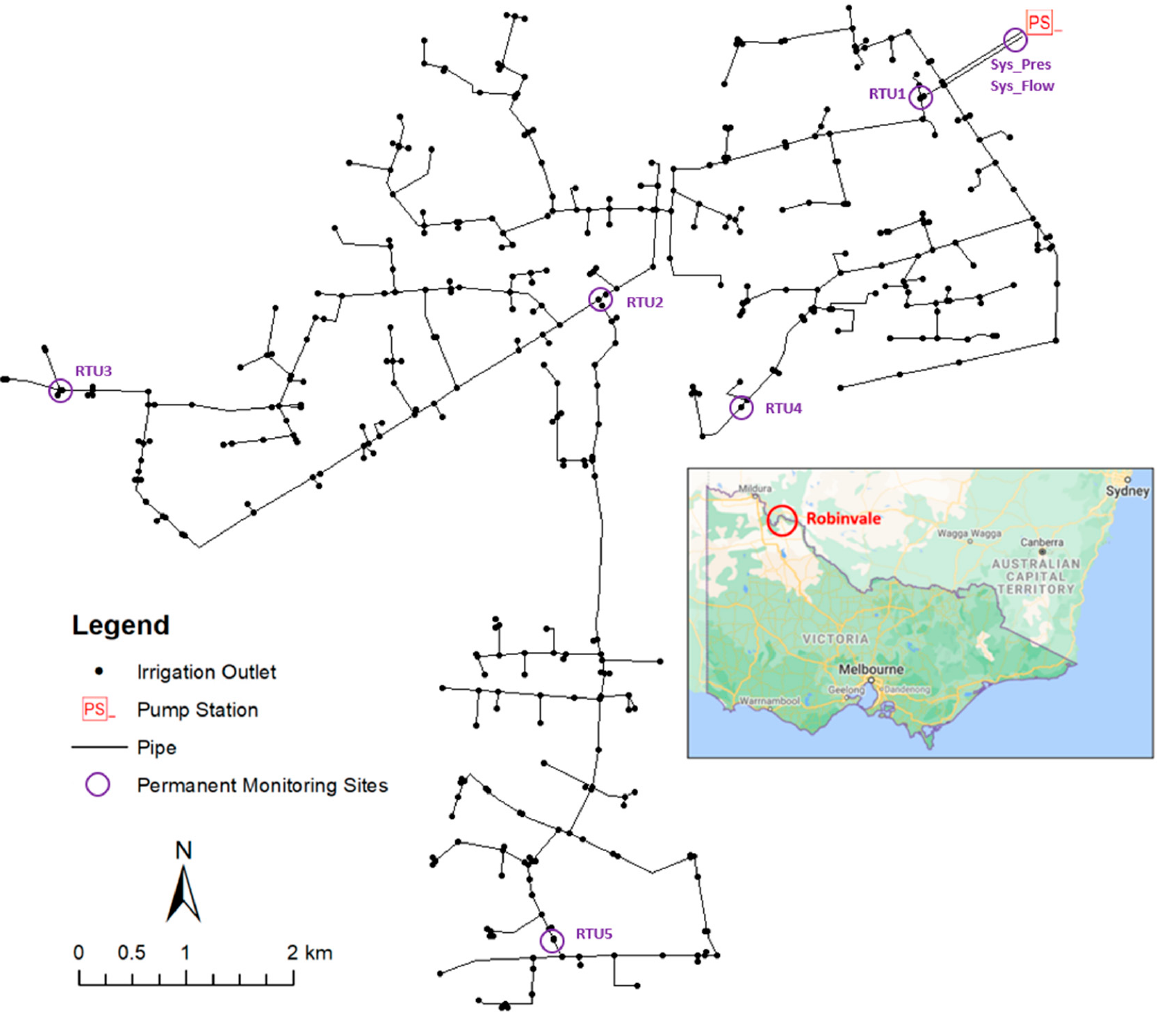
Figure 2. Case study system (the location of the system was generated with Google Maps [66], and the layout of the network was provided by LMW).